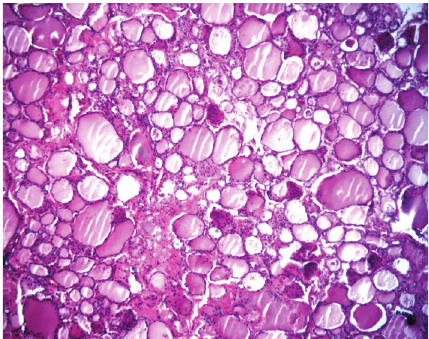
Figure 1: Case 1. Some granulomas with foreign body-type giant cells intermingled to medium-large size thyroid follicles with intra- luminal colloid, lined by single layer of follicular